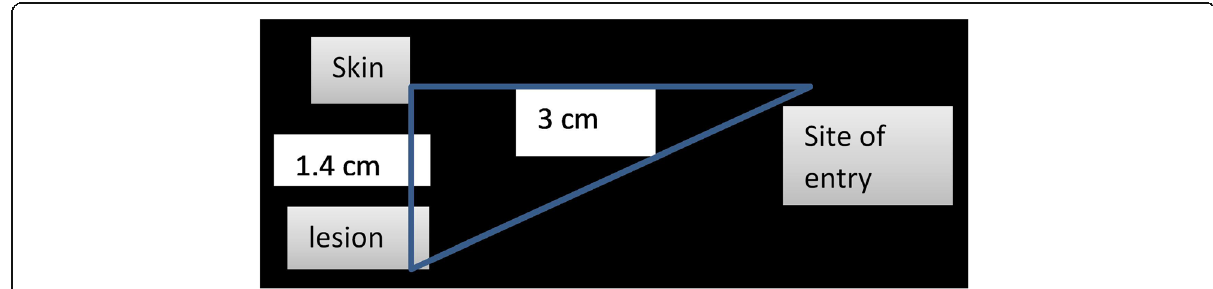
Fig. 1 Diagrammatic illustration explaining the site of entry of wire, its direction, the distance between it and the lesion, the distance between lesion and skin and, lastly the distance between the site of entry and skin